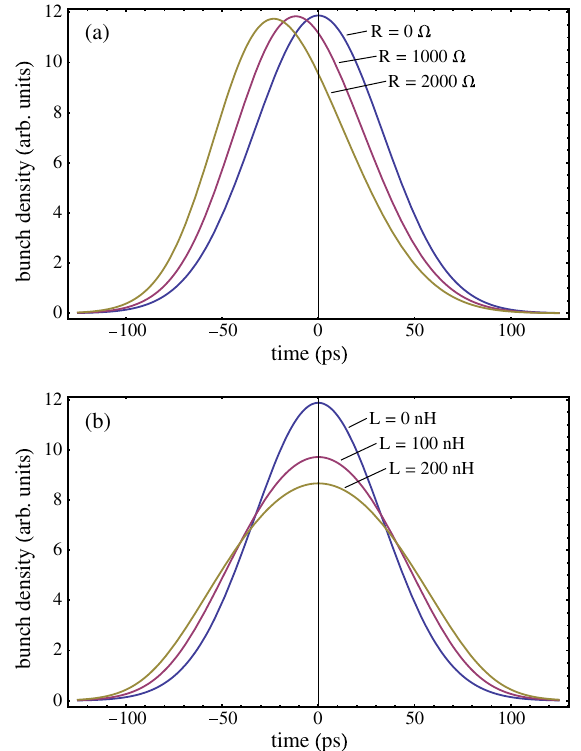
FIG. 3. Effect of (b) inductive and (a) resistive parts of the longitudinal impedance on the longitudinal profile of the bunch.